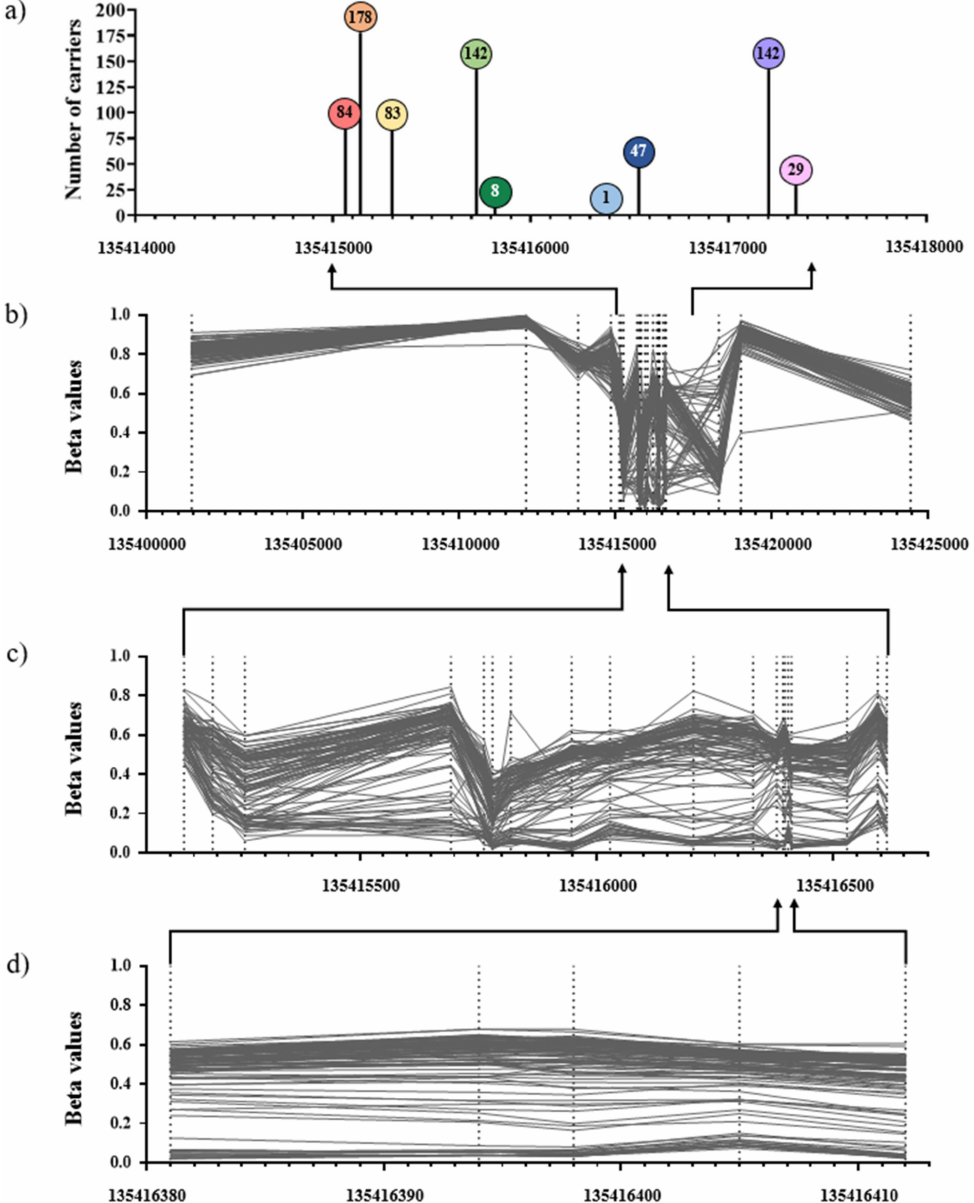
Figure 1. Genetic variants and DNA methylation at the VTRNA2-1 region. Panel ( a ) shows the 9 variants identified via sequencing in the 179 participants of the multiple-case breast cancer family studies (ABCFR/kConFab). From left to right: rs62365993, rs7706795, rs2346018, rs2346019, rs34577747, rs1366231064, rs9327740, rs4976364, and rs74555710. Numbers within lollipops indicate the number of minor alleles observed in the sample. Panel ( b )–( d ) are from a random sample of 100 participants in the population-based study (MCCS), with coordinates: ( b ) 13401437–1354244 (26 CpGs), ( c ) 135415129–135416613 (19 CpGs), and ( d ) 135416381–135416412 (the 5 most heritable methylation marks). Methylation values at the five most heritable methylation marks (cg06536614, cg26328633, cg25340688, cg26896946 and cg00124993) were highly correlated (in the MCCS all r ≥